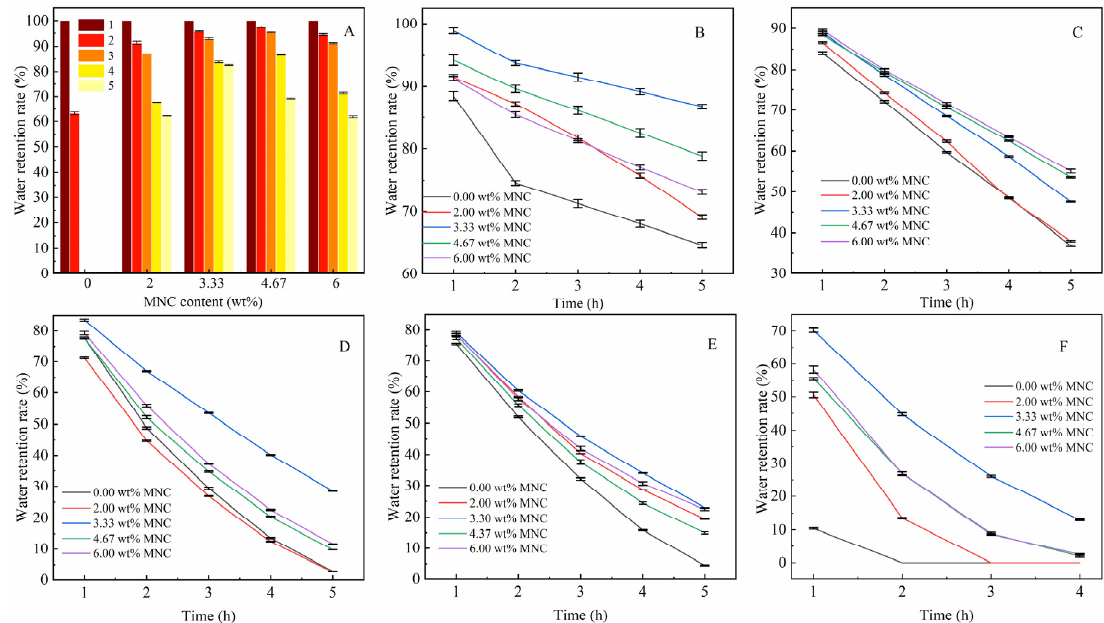
Figure 9. Swelling/drying cyclic water absorbency ( A ) and water retention rate at 20 °C ( B ), 30 °C ( C ), 40 °C ( D ), 50 °C ( E ), and 60 °C ( F ) of CAAMC.